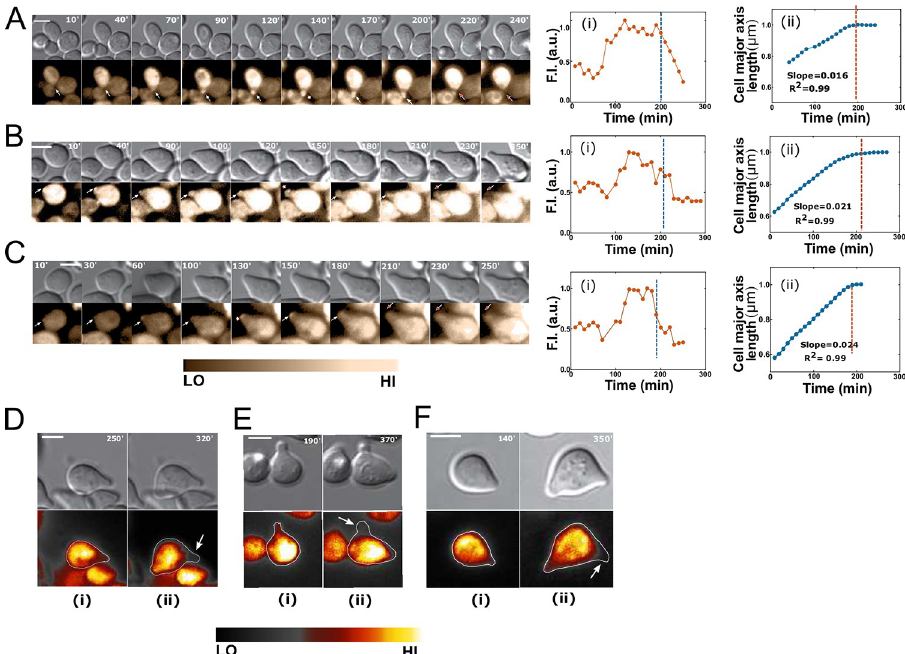
Fig 3. Ste50p localizes to the shmoo tip until shmoo maturation. Ste50p-GFP-expressing cells were treated with 2 μ M α -factor and imaged using time-lapse microscopy. (A-C) Single cells with indicated intervals in minutes showing Ste50p patches at the shmoo tip (white arrows); the white asterisk ( � ) indicates signal peak; the red arrow indicates receding of Ste50p from the shmoo (S7–S9 Movies). (Ai-Ci) Quantified GFP fluorescence at the shmoo tip (~0.2– 0.3 μ m 2 area at the tip; see S2 File) showing a peak Ste50p around 130–200 min after pheromone treatment that starts receding around 200 min (blue broken lines). (Aii-Cii) Correlation between the disappearance of Ste50p from the shmoo and the termination of polarized shmoo growth (orange broken lines indicate start of shmoo growth inhibition; see text); the major cell axis ( μ m) versus time (min) have been plotted (4 point rolling average); both shmoo Ste50p and growth normalized to the maximum values for each cell; linear regression fit to the linear subset of data (length when shmoo extension started until when it stopped) showing the rate of shmoo growth, slope = 0.016, 0.021 and 0.023, respectively. (Di-Fi) Cytoplasmic Ste50p retracted from the 1 st shmoo and relocalized to the 2 nd shmoo (pronounced around 270–320 min; white arrow indicates 1 st shmoo) (Dii-Fii). Scale bar represents 5 μ